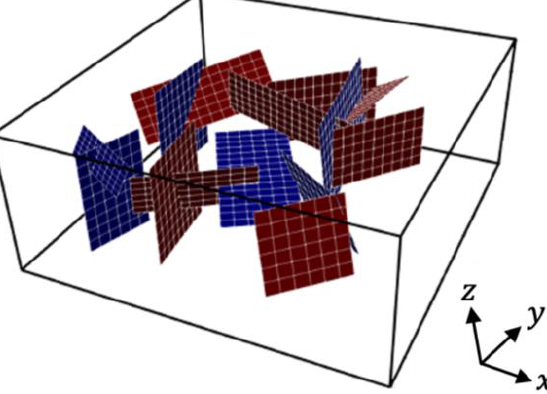
Figure 7. Schematic of fracture geometry applied in the multiphase test case. The highly conductive fractures are shown in red color and the impermeable ones are colored in blue. Table 2. Input parameters used in the multiphase flow test case. Thermodynamic properties for water of liquid and vapor phase are referred to [40].